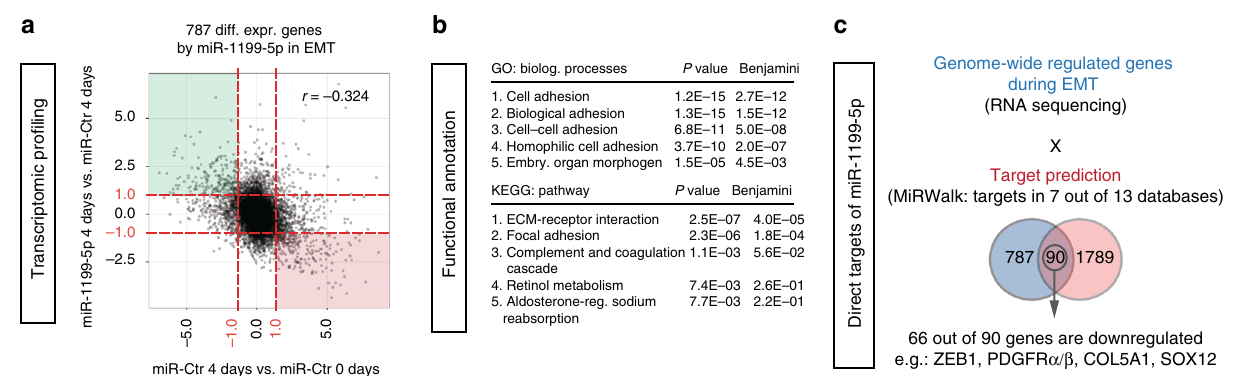
Fig. 3 Targets of miR-1199-5p function during an EMT. a Overall gene expression regulation by miR-1199-5p during a TGF β -induced EMT. RNA-sequencing analysis was performed on NMuMG/E9 cells transiently transfected with a miR-1199-5p or a negative control (miR-Ctr) mimic. Cells were cultured for 4 days in the presence (4 days; miR-Ctr- and miR-1199-5p-transfected cells) or absence of TGF β (only miR-Ctr-transfected cells). The scatterplot depicts overall gene expression (log2FC) anti-correlation between miR-1199-5p 4 days vs. miR-Ctr 4 days over miR-Ctr 4 days vs. miR-Ctr 0 days. Differential expression analysis (red dashed line: log2FC( ± 1); False Discovery Rate (FDR) < 0.05) identi fi ed 787 genes regulated by miR-1199-5p during an EMT. Green quadrant: increased gene expression; red quadrant: decreased gene expression. b Functional annotation clustering analysis of differentially expressed genes from a . Gene ontology (GO) and Kyoto Encyclopedia of Genes and Genomes (KEGG) pathway analyses by DAVID for the top fi ve biological processes (top), pathways (bottom) and their associated P and Benjamini – Hochberg values. c Identi fi cation of miR-1199-5p direct targets in EMT. The Venn diagram depicts the number of genes differentially expressed upon miR-1199-5p expression during an EMT (blue), predicted direct targets of miR-1199-5p by miRWalk2.0 (red) and the number of overlapping genes. Sixty-six out of 90 genes demonstrate a downregulation in their expression upon forced expressed of miR-1199-5p in EMT, including the EMT TF